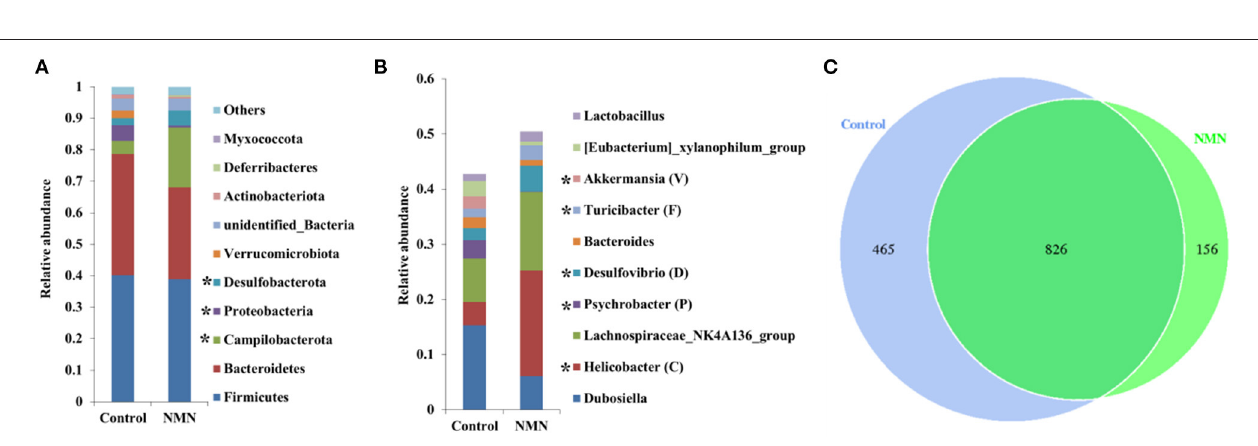
FIGURE 4 | Supplementary effect of NMN on the fecal microbiota in pre-aging mice. (A) Alpha diversity indexes, (B) Beta diversity indexes. **Indicates significant difference at p < 0.01.